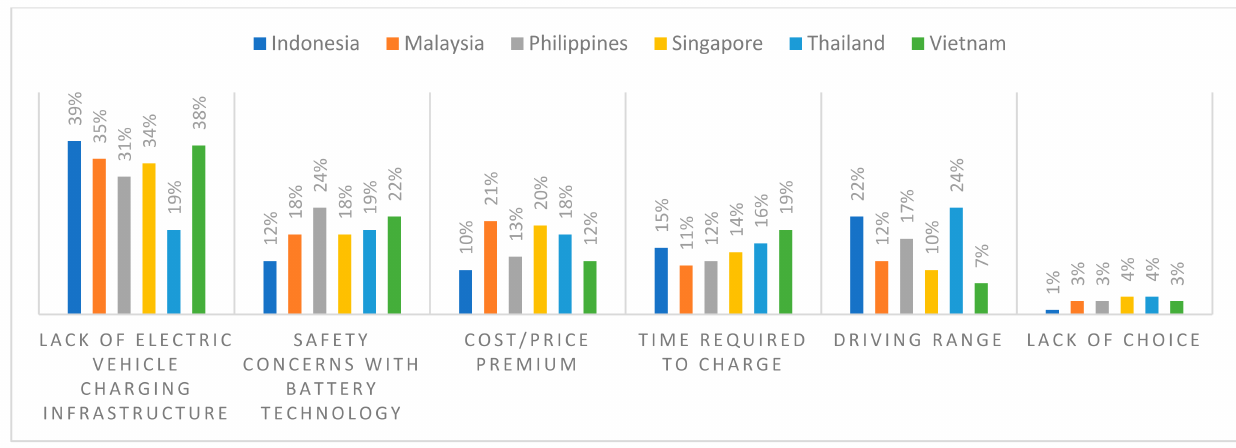
Figure 9. Consumers’ top concerns for the adoption of EV in selected ASEAN countries. Source: https://www2.deloitte.co m/content/dam/Deloitte/sg/Documents/strategy/sea-strategy-operations-full-speed-ahead-report.pdf (accessed on 4 November 2021)